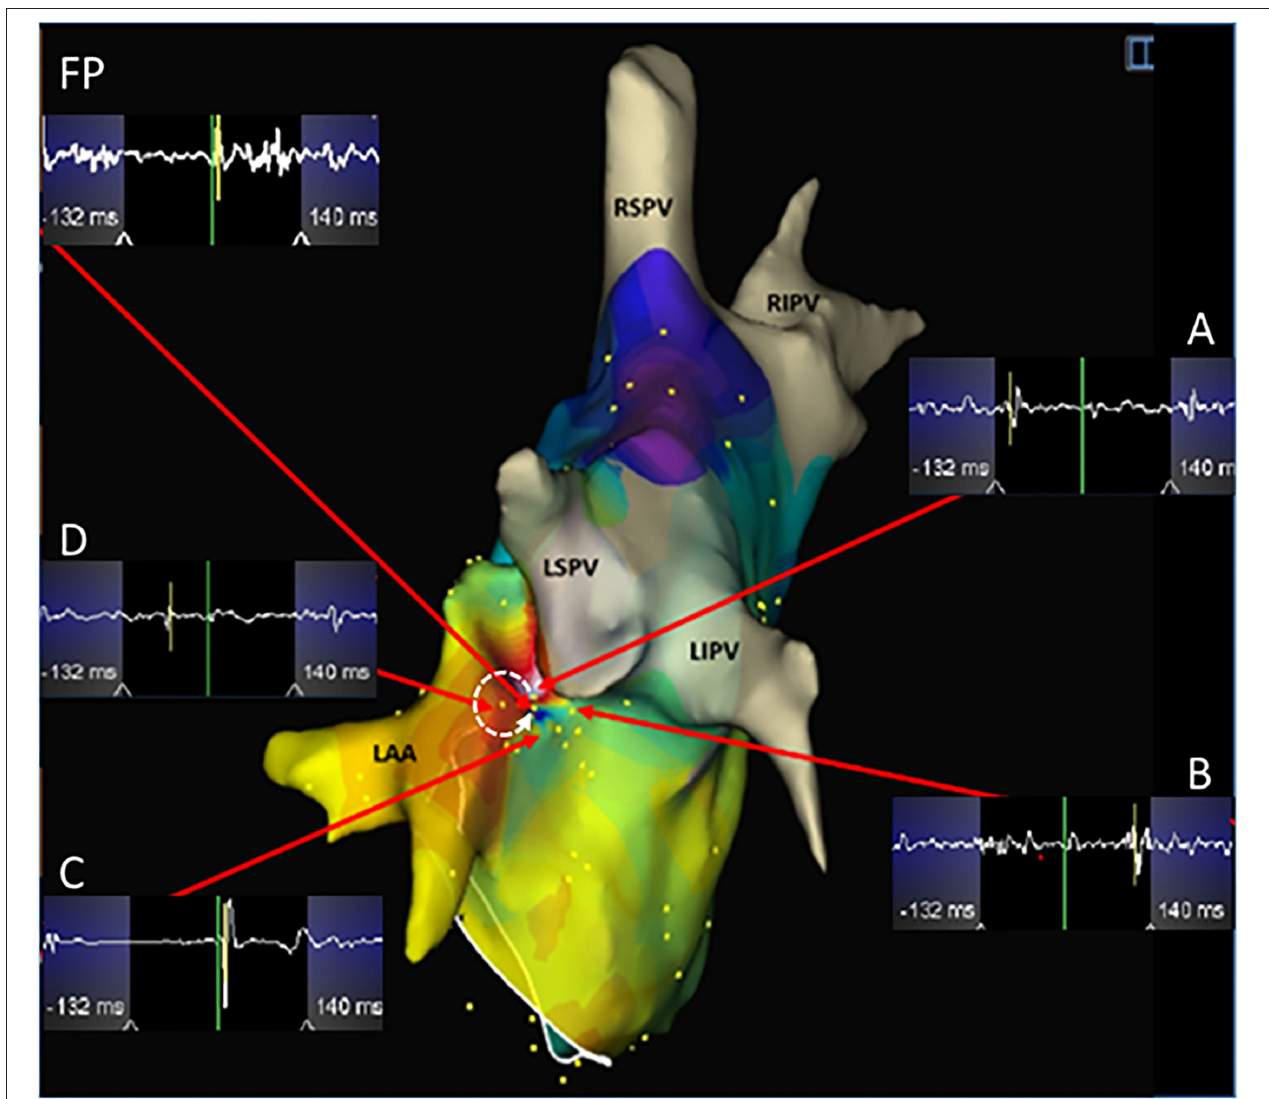
FIGURE 3 | A microreentrant atrial tachycardia located between the left atrial appendage and the left superior pulmonary vein was shown by the EnSite NavX system. A whirlpool-like reentry around a tiny core was displayed with the earliest (white) connected to the latest activation (purple) in an area with a diameter of < 10mm. A wide fractionated potential was recorded connecting the earliest and the latest activation sites. Cross-mapping was used and the local activation time at sites A, B, C, and D measured at -110, 112, 14, and -56ms, respectively. The dotted arrow shows the activation direction from A to D and further to C and B in sequence. Ablation targeting the FP terminated the atrial tachycardia. LIPV, left inferior pulmonary vein. Abbreviations as shown in Figures 1 , 2